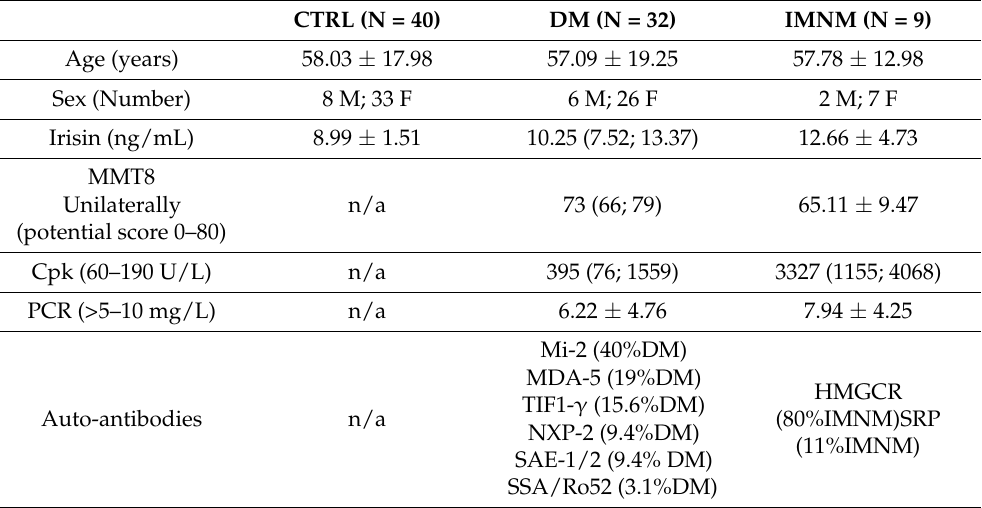
Table 1. Demographic, anthropometric, skeletal muscle mass, and laboratory parameters of patients. Mean ( ± SD) or median (25%; 75%) for all variables.